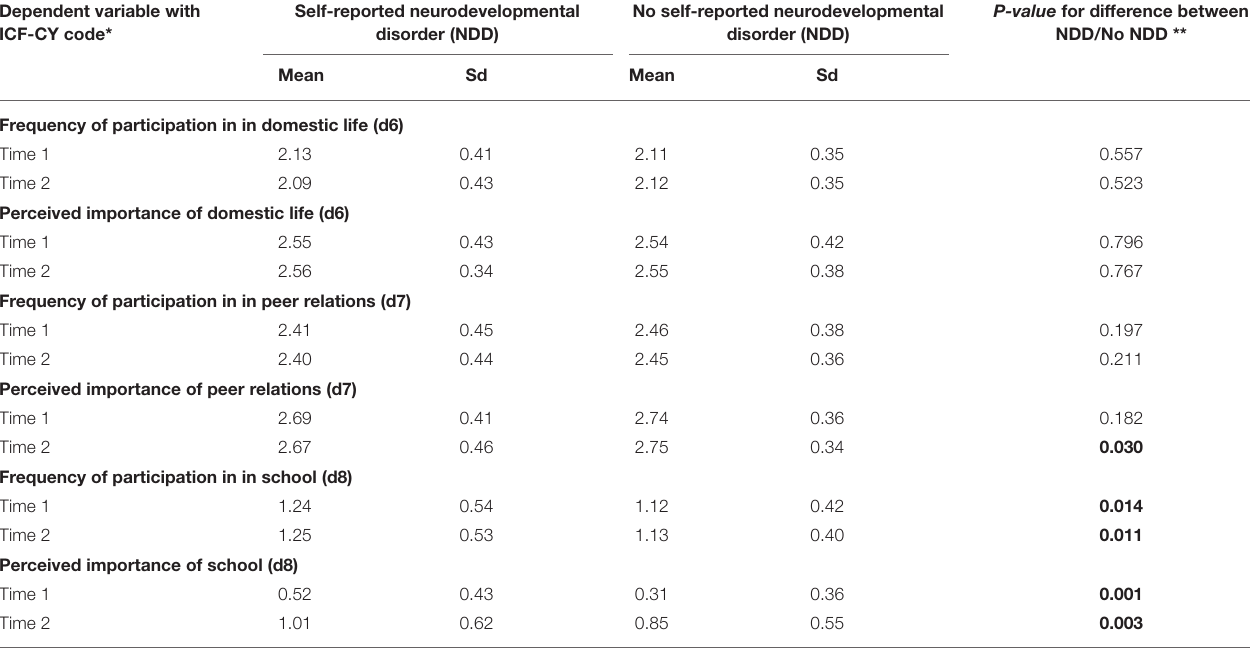
TABLE 3 | Descriptive statistics for dependent variables regarding participation at home, with peers and in school. Dependent variable with ICF-CY code*